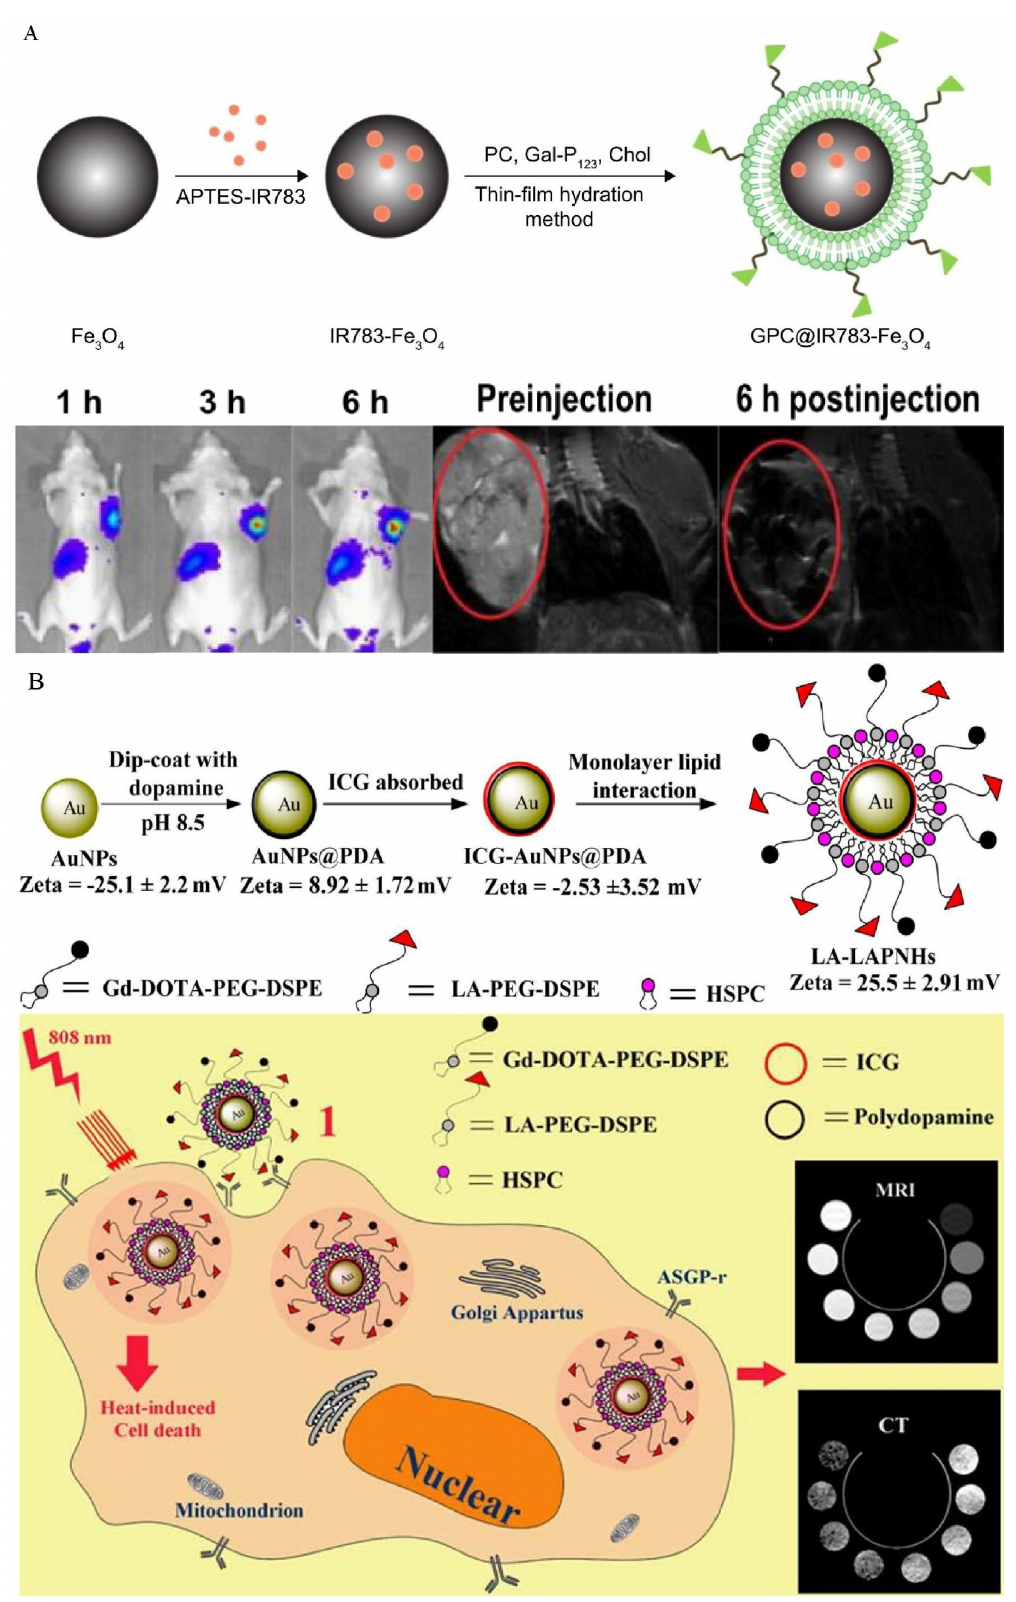
Figure 12. ( A ) The synthesis of MRI/NIRF dual-modal probe and effect of imaging. Reproduced with permission [82]. Copyright 2018, Dovepress. ( B ) The composition of MRI/CT dual-modal probe and theranostic mechanism. Reproduced with permission [83]. Copyright 2014, American Chemical